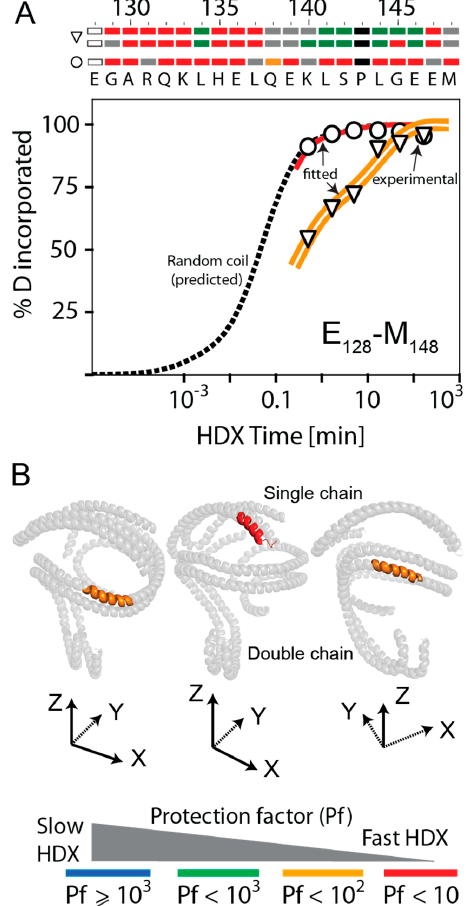
Figure 5. Kinetic curves and HDX residue protection factors for peptide E 128 –M 148 . The color-coding legend of the curves is shown at the bottom of the figure. ( A ) Peptide E 128 –M 148 exhibited bimodal and biphasic HDX kinetics (red and orange curves). The faster-exchanging peptide (red) behaved like a random coil peptide and was predicted to originate from the apoA-I hairpin, while the slower exchanging peptide was predicted to come from the helical double chain (orange double line). ( B ) The apoA-I domain E 128 –M 148 identified to exhibit bimodal HDX kinetics in rHDL, as shown mapped on the three apoA-I chains of rsHDL (HpHd model). The domain was predicted to exchange fast when located in the hairpin monomer (the majority of residues were colored red) but was exchanging slower when located on the apoA-I helical dimer (many of its residues were colored green). In a previous publication [18], we reported that the apoA-I domain L 159 –A 180 , the binding site for